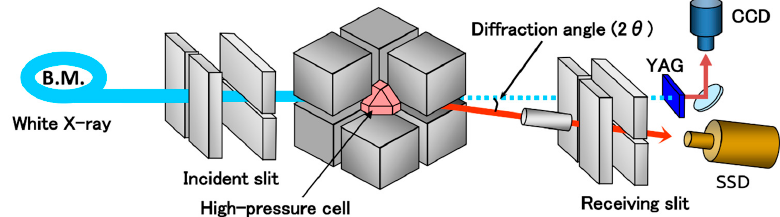
Figure 1. Schematic layout of the beamline. White X ‐ rays emit from the bending magnet (B.M.), which are conditioned by incident slits to enter the high ‐ pressure cell. Transmitted X ‐ rays are used to image the sample cell, converted by a scintillator, YAG, and recorded by a camera, CCD. A fixed diffraction angle, 2 θ , is selected by a collimator and receiving slits in front of the solid state X ‐ ray detector, SSD. After [49].